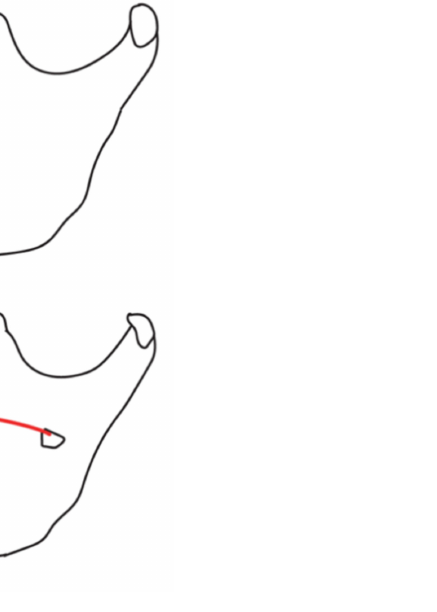
Figure 3. Schematic view of oblique mandibular osteotomy modo Obwegeser–Epker